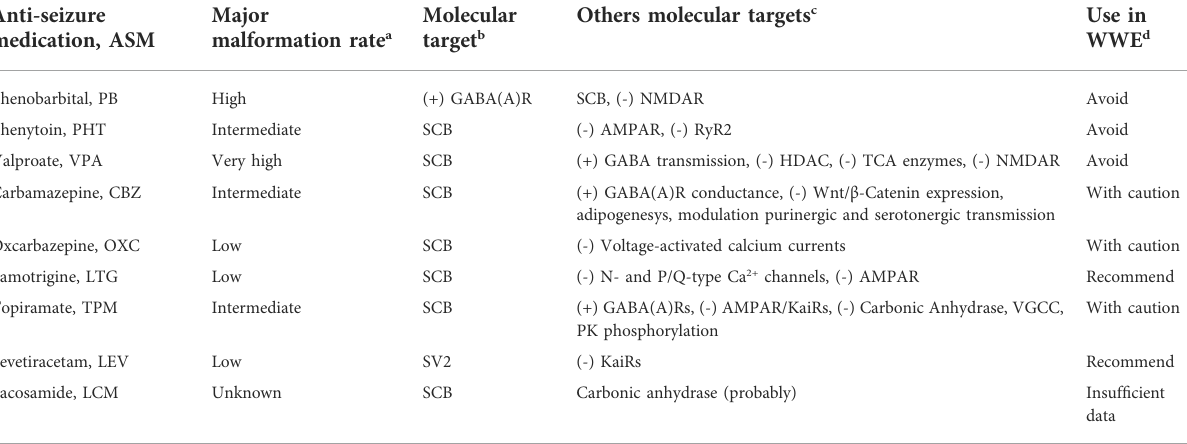
TABLE 1 Teratogenic and pharmacological mechanism of action of anti-seizure medication. Anti-seizure medication,